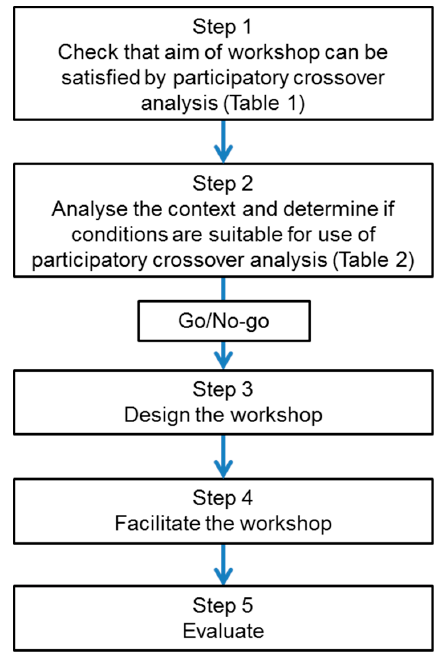
Figure 1. Stepwise framework for participatory crossover analysis.